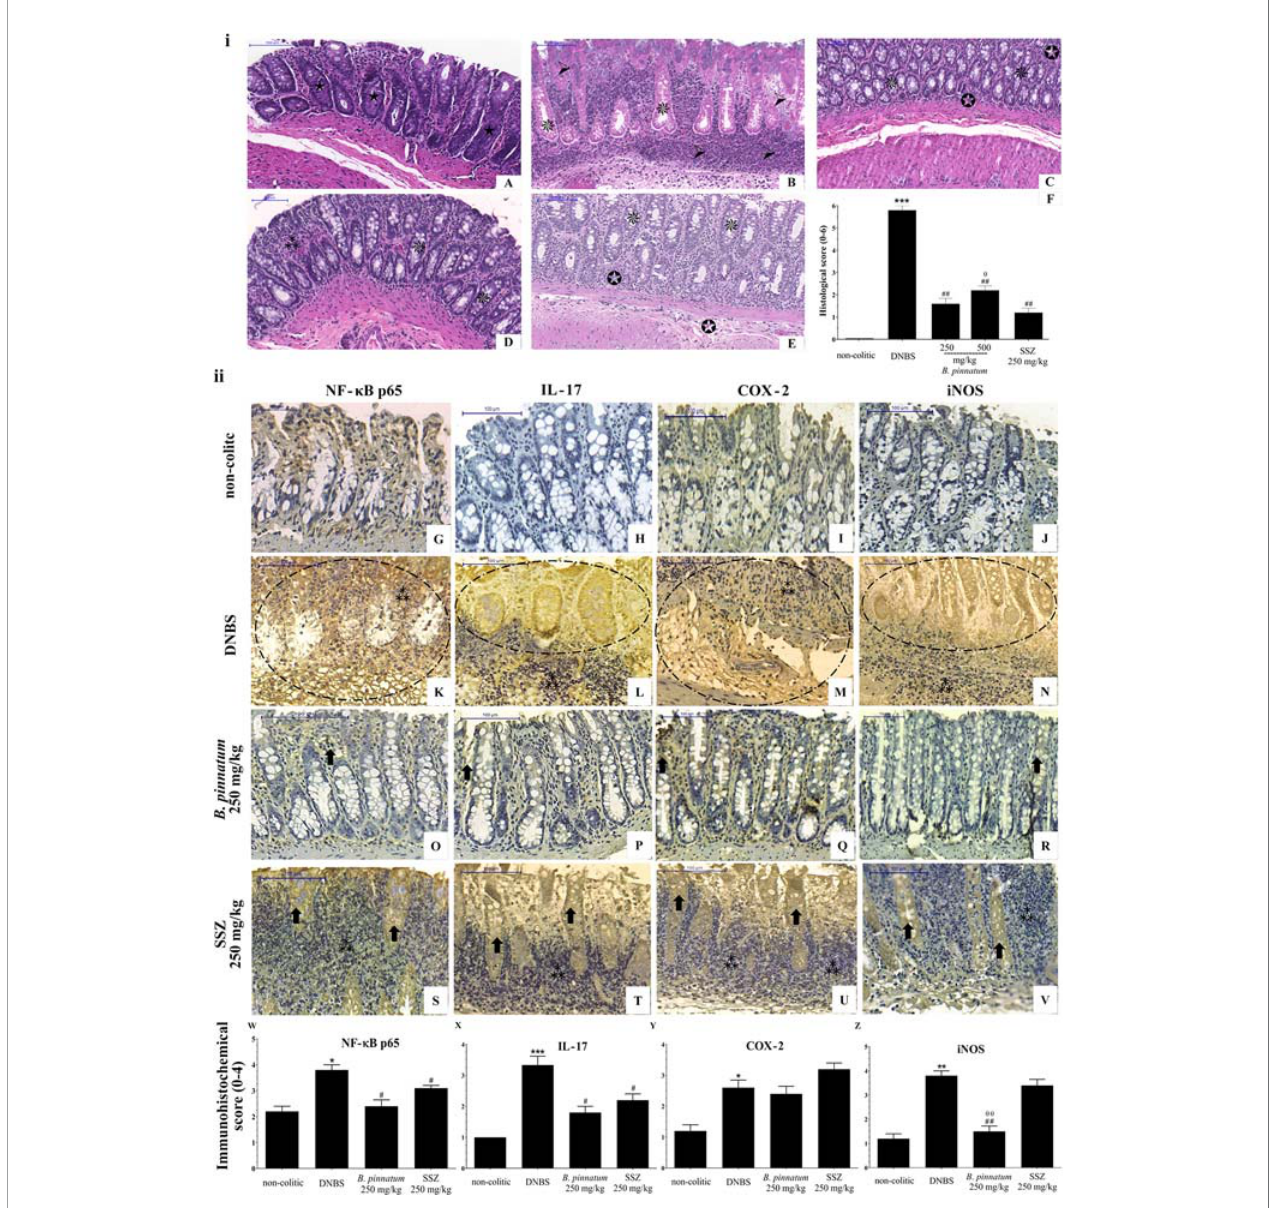
FIGURE 5 | Histopathologic features of representative samples of colonic tissue ( i ), showing the colon fragment cut in the longitudinal direction and stained with Hematoxylin/Eosin; scale 100 m m: non-colitic (A) , 2.4-dinitrobenzene sulfonic acid (DNBS) (B) , hydroethanolic extract from B. pinnatum leaf (HEBP) 250 and 500 mg/kg (C – D) , SSZ 250 mg/kg (E) , and evaluation of microscopic damage (F) . Normal intestinal layers ( ), diffused active colitis with super fi cial erosions, stromal edema, dense acute and chronic in fl ammatory cells in fi ltrate with widely ( ), moderate ( ), light ( ) ulcerating mucosa, and loss of goblet cells ( ). Immunohistochemical analysis of colonic tissue and immunohistochemistry scores ( ii ). Scale bar 100µm. The non-colitic (G-J) , DNBS (K – N) , HEBP 250 mg/kg (O – R) and SSZ 250 mg/kg (S – V) groups were analyzed by immunoreactivity for NF- k B p65, IL-17, COX-2, and iNOS. Arrows indicate antibody reactivity, indicates area of intense in fl ammatory cell in fi ltration, dashed areas indicate ulceration. Data (n = 8) are presented as mean ± standard error from the mean. * p < 0.05, ** p < 0.01, *** p < 0.001, compared with non-colitic group; # p < 0.05, ## p < 0.01, compared with DNBS group; q p < 0.05, qq p < 0.01, compared with SSZ 250 mg/kg